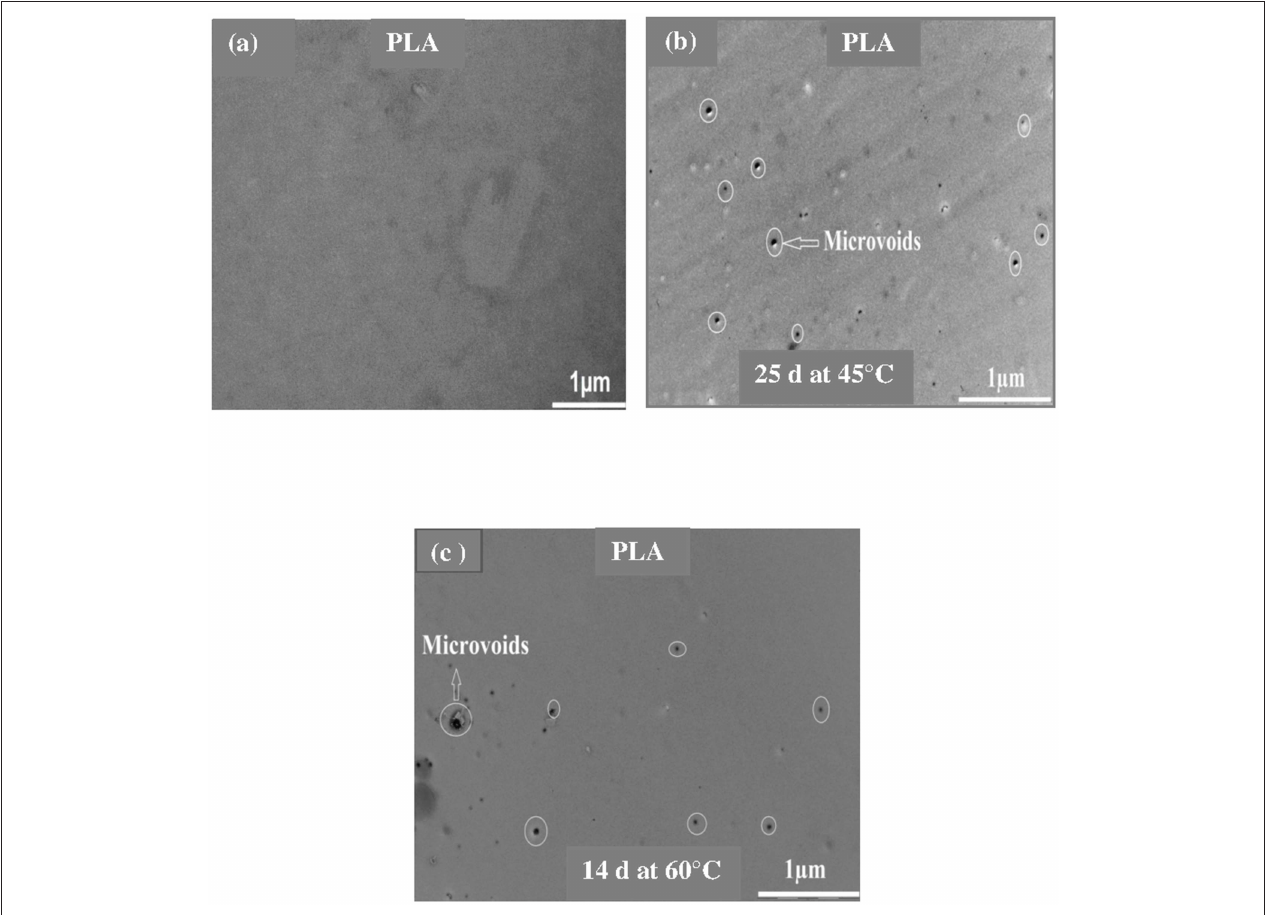
FIGURE 6 | TEM images of a PLA fiber. (a) Before exposure, (b) after 25 days at 45 ◦ C, and (c) 14 days at 60 ◦